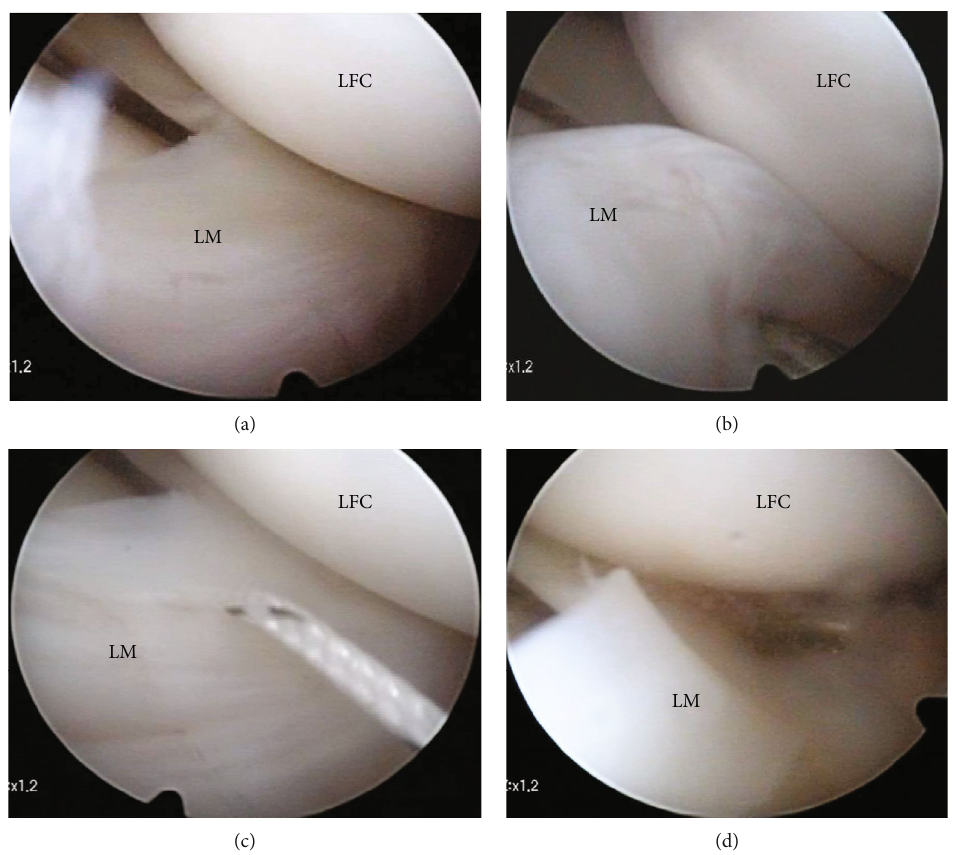
Figure 4: Arthroscopic stabilization of a hypermobile anterior horn of the lateral meniscus. (a) No tear in the anterior lateral meniscus; (b) Evaluation using the probe showed hypermobility at the anterior horn of the lateral meniscus; (c) Meniscus stabilization was performed by the outside-in technique with two stitches using a strong suture; (d) After stabilization, the hypermobility of the anterior horn of the lateral meniscus was resolved. LM: lateral meniscus; LFC: lateral femoral condyle; LTP: lateral tibial